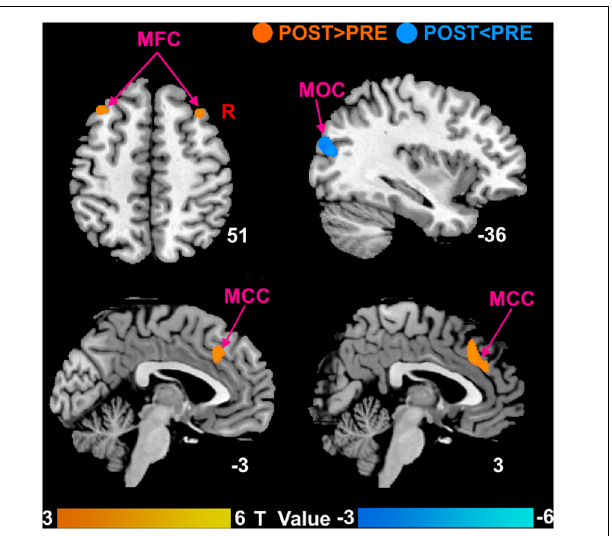
FIGURE 3 | Brain responses to true moxibustion treatment. MFC, middle frontal cortex; MCC, middle cingulate cortex; MOC, middle occipital cortex; POST, patients with MCI after moxibustion treatment; PRE, patients with MCI before moxibustion